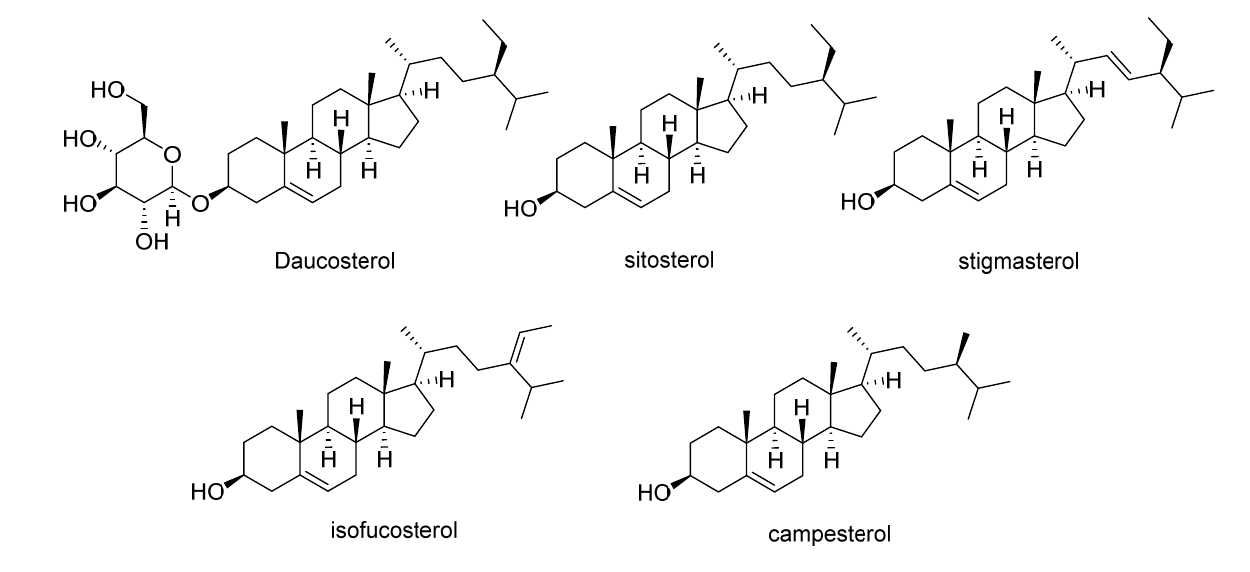
Figure 5. Main phytosterols identified in sweet potato.